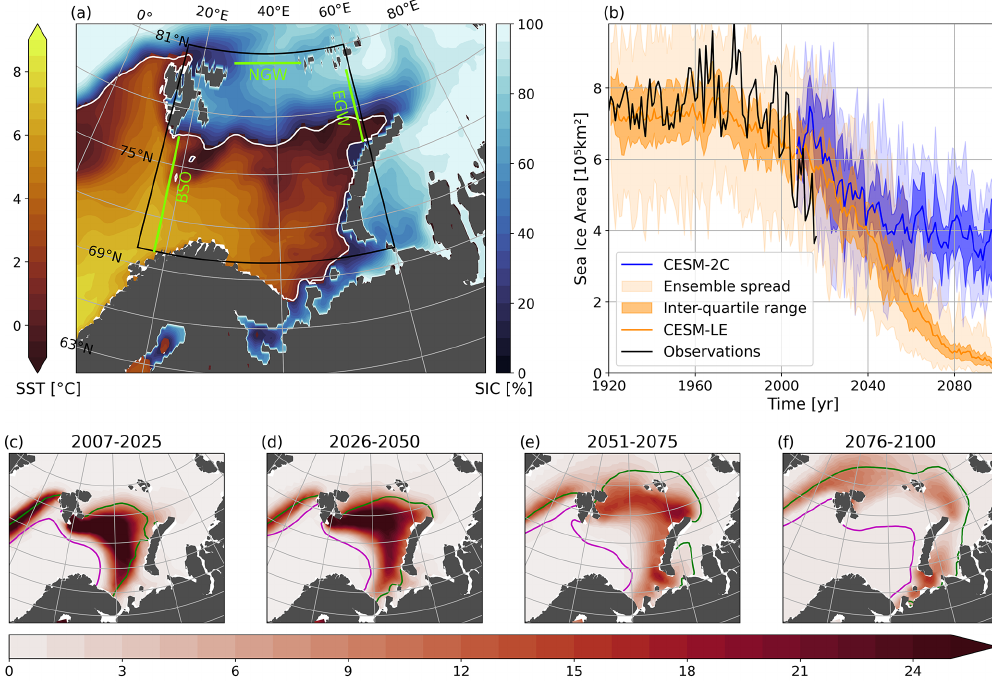
Figure 1. (a) Observed winter (November–April) mean sea ice concentration (SIC; Walsh et al., 2017) and sea surface temperature (SST; Hersbach et al., 2019) in the Barents Sea (black box) between 2013 and 2017. Note the two different color bars. The white line indicates the mean location of the winter sea ice edge (15% SIC). (b) Winter SIA in the Barents Sea from observations, CESM-LE, and CESM-2C. (c–f) Occurrence of strong 5-year trends in SIC ( ≥ 8%yr − 1 ) during different time periods of the CESM-LE simulations. The colored lines indicate the southernmost (magenta) and northernmost (green) location of the ice edge during the respective time periods.